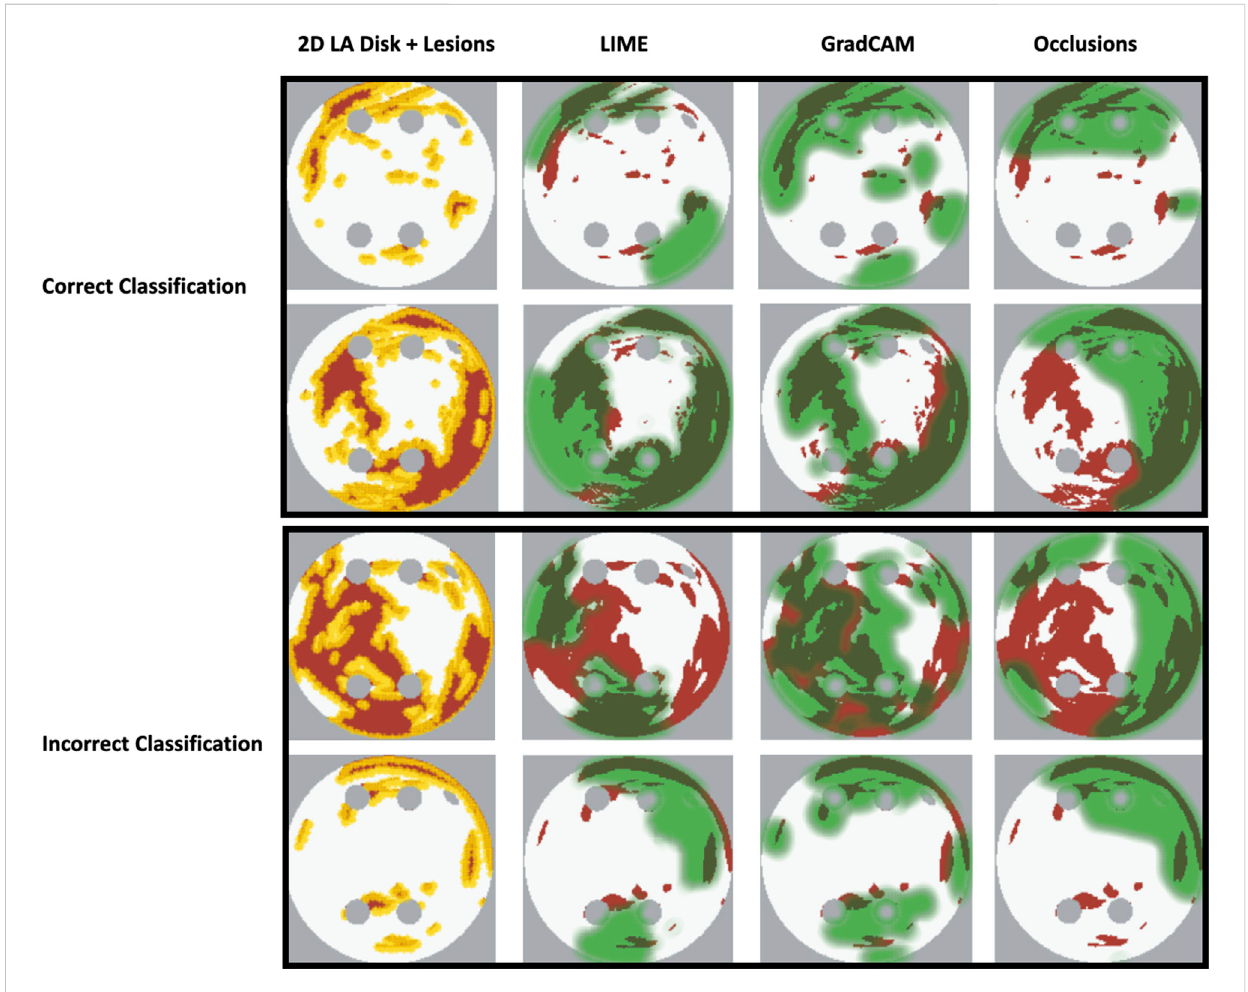
FIGURE 10 Correct and incorrect classi fi cation examples of FA maps (LIME, GradCAM and occlusions) for FIBRO.